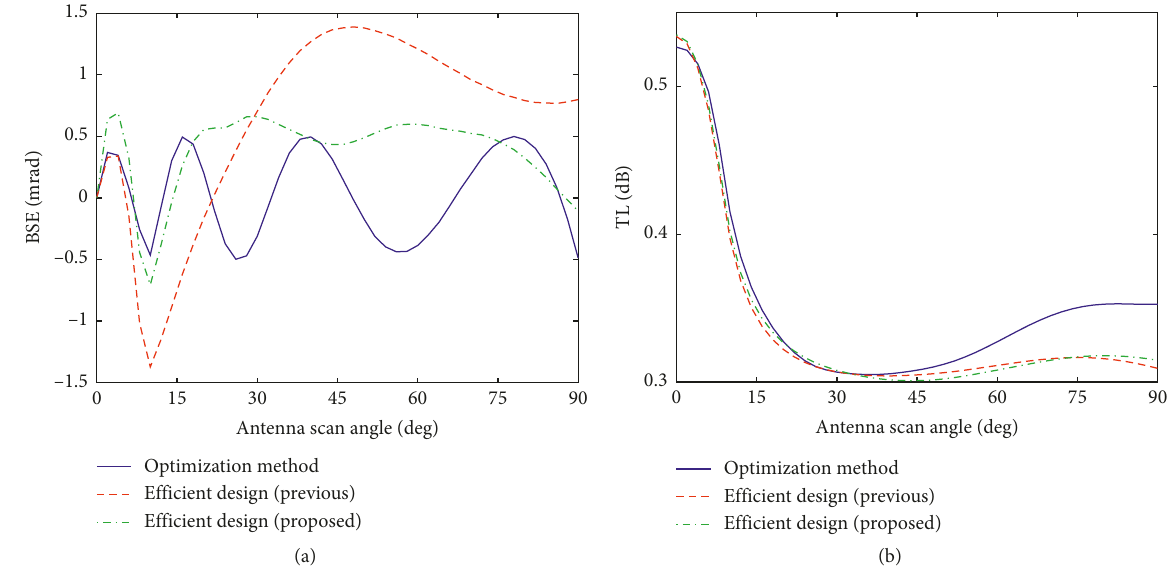
Figure 8: EM performance of VTRs obtained by different methods. (a) BSE. (b) TL. Table 2: Results of different